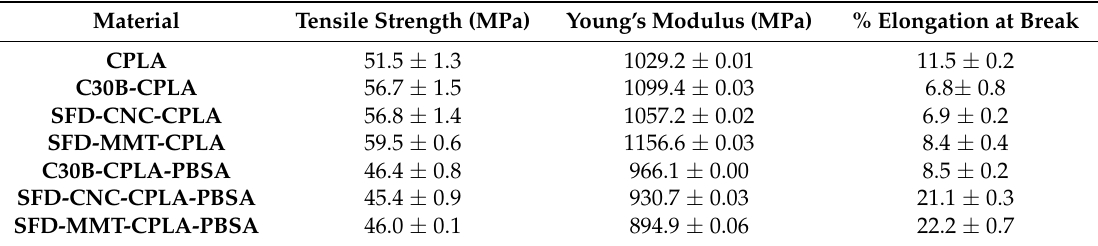
Table 4. Mechanical results for PLA